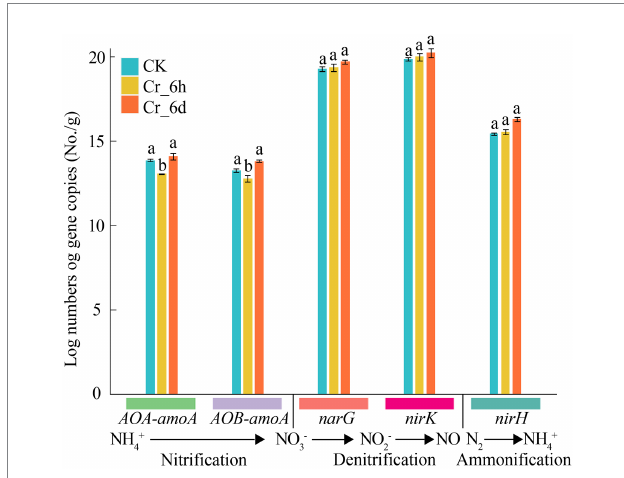
FIGURE 3 Abundance of functional genes involved in nitrogen cycling in chromium-contaminated soils. Error bars represent standard errors ( n = 3); different lowercase letters indicate significant differences between components ( p < 0.05).